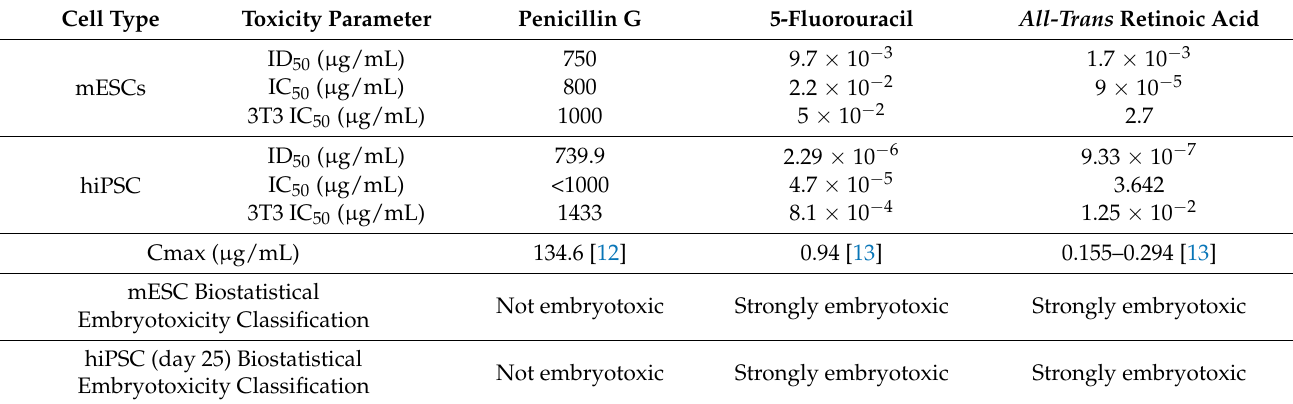
Figure 4. 5-FU and at RA treatment reduced hiPSC-cardiomyocyte and hFF viability in a dose-dependent manner as as- sessed via MTT assay. ( A ) hiPSC viability screens for 5-FU, at RA, and PenG, n = 3 biological replicates ± SD. *: p < 0.05 = the lowest concentration significantly below the untreated hiPSC control group as determined by One-Way ANOVA. ( B ) hFF viability screens for 5-FU, at RA, and PenG, n = 3 biological replicates ± SD. *: p < 0.05 = the lowest concentration significantly below the untreated hFF control group as determined by One-Way ANOVA. hiPSC, human induced plu- ripotent stem cell; MTT, mitochondrial dehydrogenase activity assay; 5-FU, 5-fluorouracil; at RA, all-trans retinoic acid; PenG, penicillin G; hFF, human foreskin fibroblast.